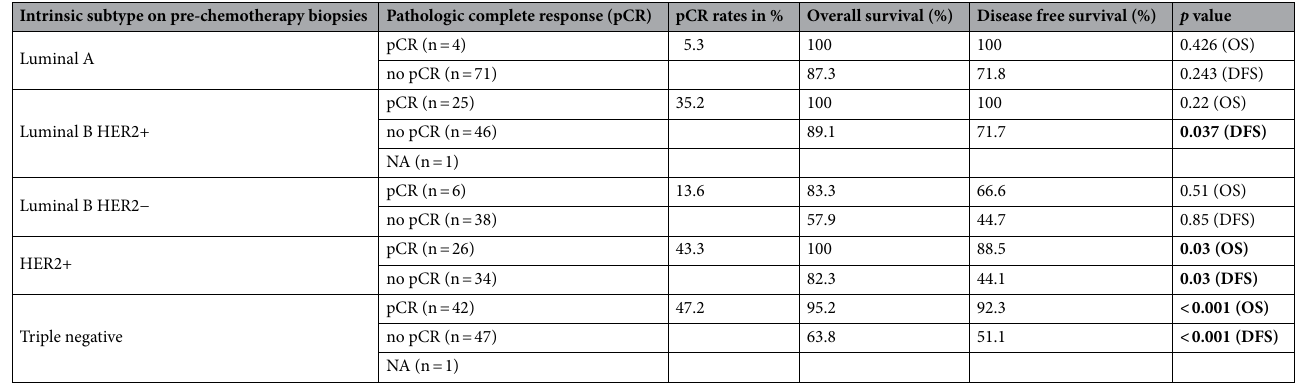
Table 4. Pathological complete response (pCR), overall survival (OS) and disease free survival rates (DFS) rates among the different subtypes overall and in subgroups. p values < 0.05 (bold labeled) are significant.